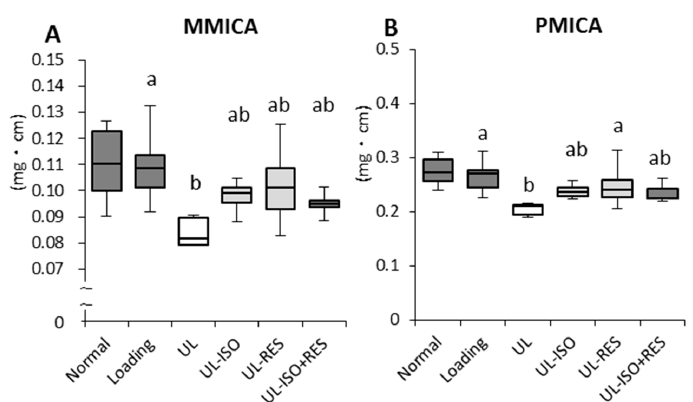
Figure 3. Bone strengths in femur in hindlimb-unloading mice. Bone strength parameters were measured by micro-computed tomography scanning. ( A ) Minimum moment of inertia of cross-sectional areas (MMICA). ( B ) Polar moment of inertia of cross-sectional areas (PMICA). Normal, normally housed group; Loading, loading group; UL, hindlimb-unloading mice fed a control diet; UL-ISO, hindlimb-unloading mice fed a 0.16% soy-isoflavones conjugates diet; UL-RES, hindlimb-unloading mice fed a 0.15% RES diet; UL-ISO + RES; hindlimb-unloading mice fed a 0.16% soy-isoflavones conjugates and resveratrol diet. Values are the mean ± SEM (n = 6 – 8). The data were analysed using one-way analysis of variance (ANOVA). The Normal group was not included in the statistical analyses. Differences among the groups were assessed by Tukey’s post hoc test. If variances were not equivalent, the data analysed Kruskal–Wallis ANOVA, and followed by a Steel-Dwass test. Differences were considered significant when P < 0.05. a, b Mean values with unlike letters were significantly different.